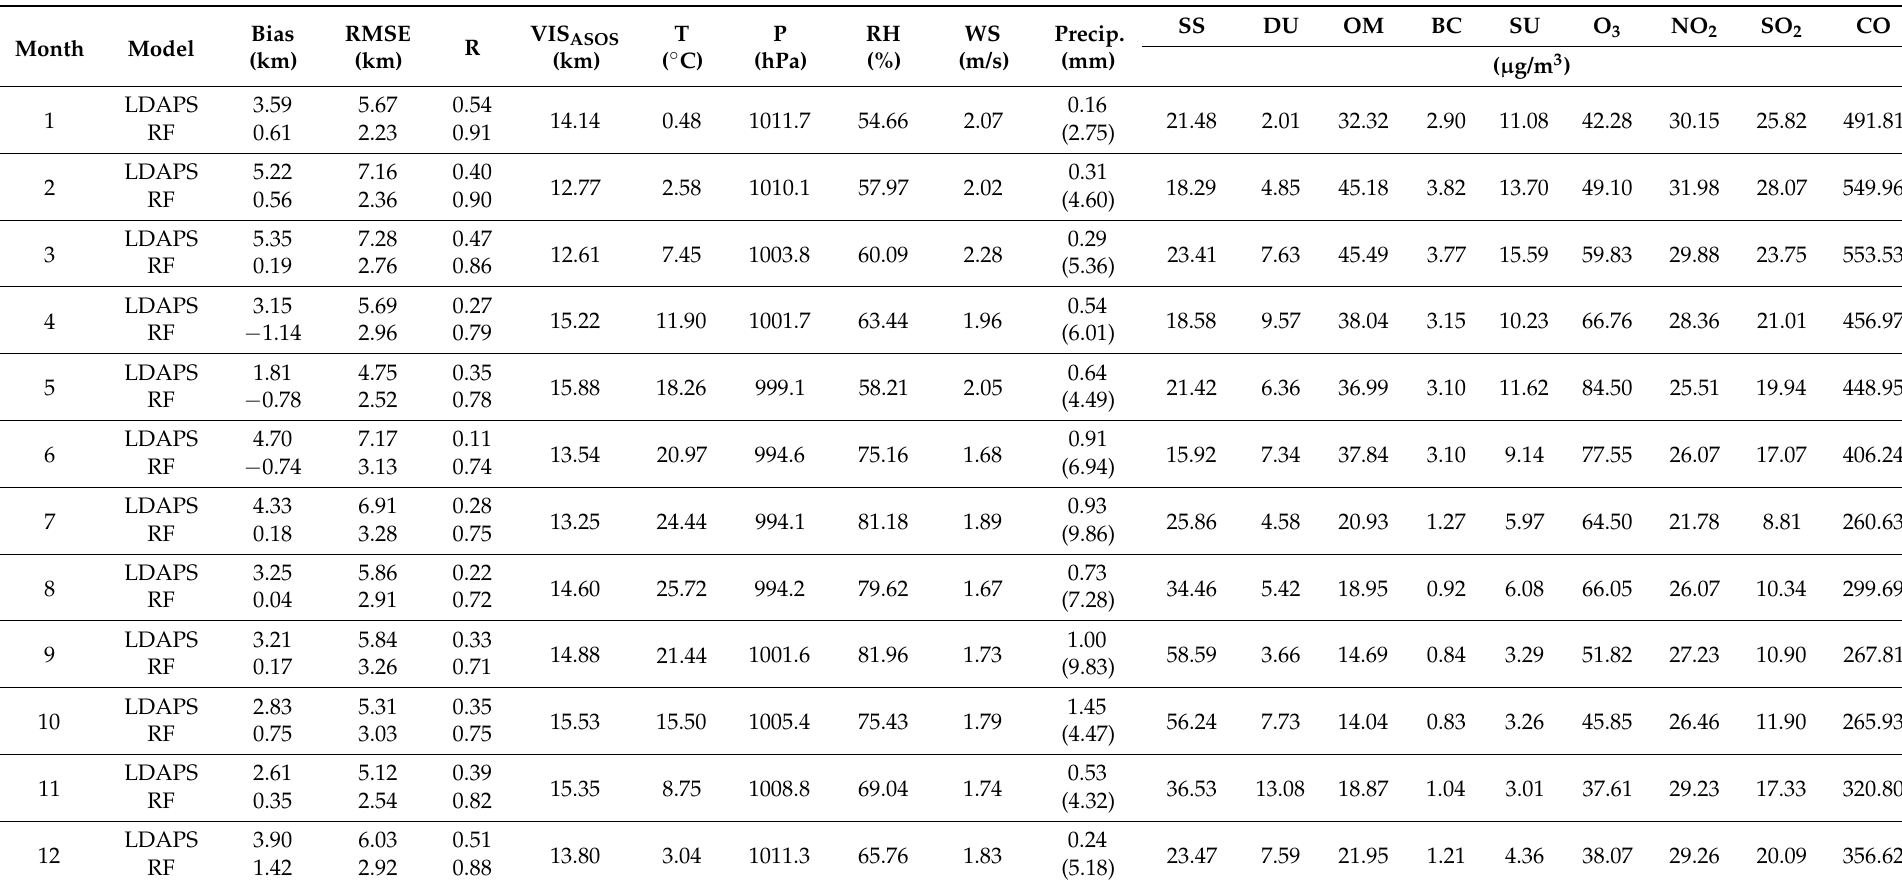
Table 2. Monthly comparisons of VIS ASOS , VIS LDAPS , and VIS RF (showing bias, RMSE, and R) and monthly mean data for the meteorological variable inputs in the VIS RF model. Parentheses values in precipitation are the number of precipitation